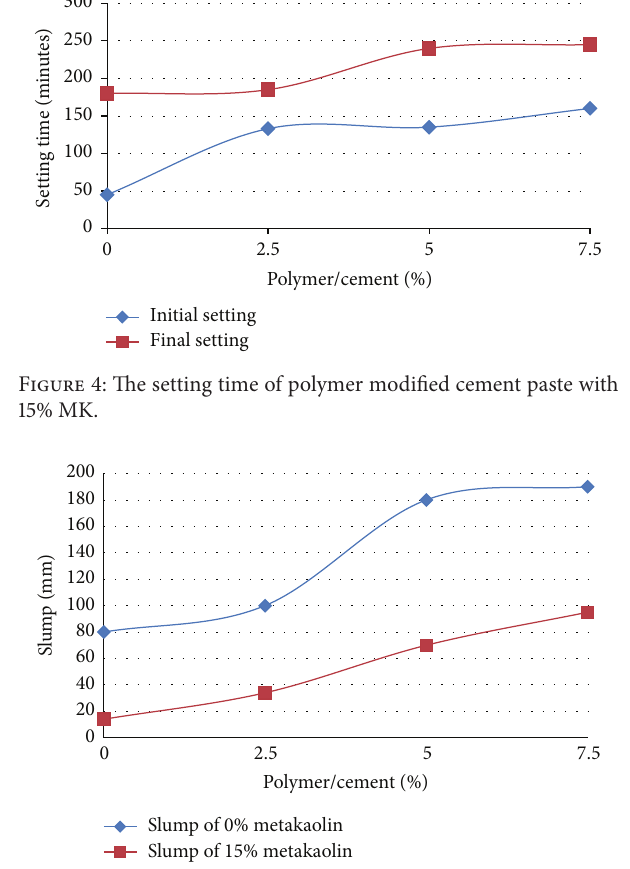
Figure 8: The compressive strength at different MK contents and 0%